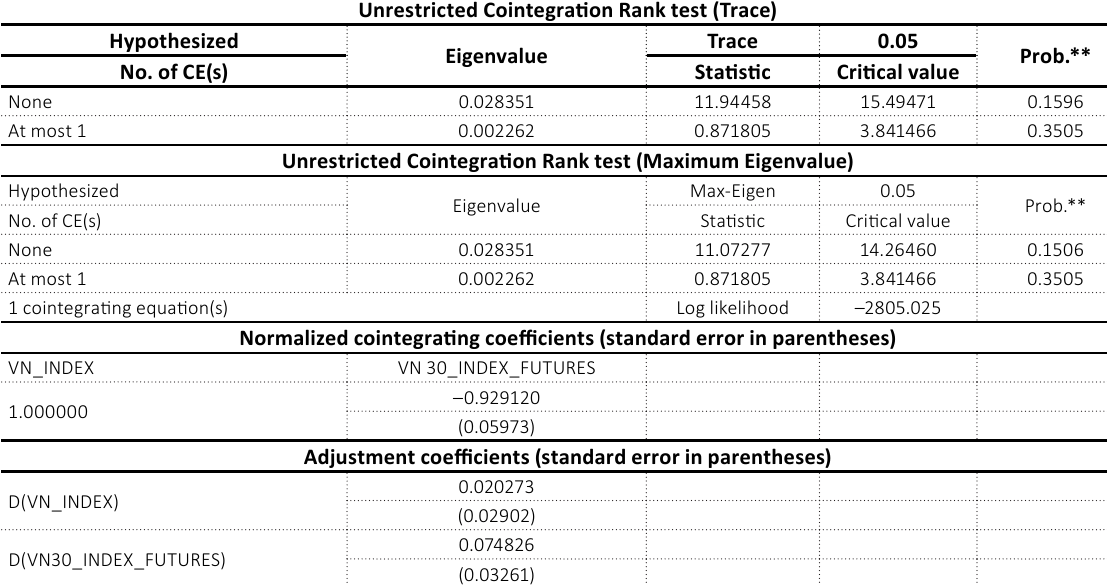
Source: Results calculated from EViews